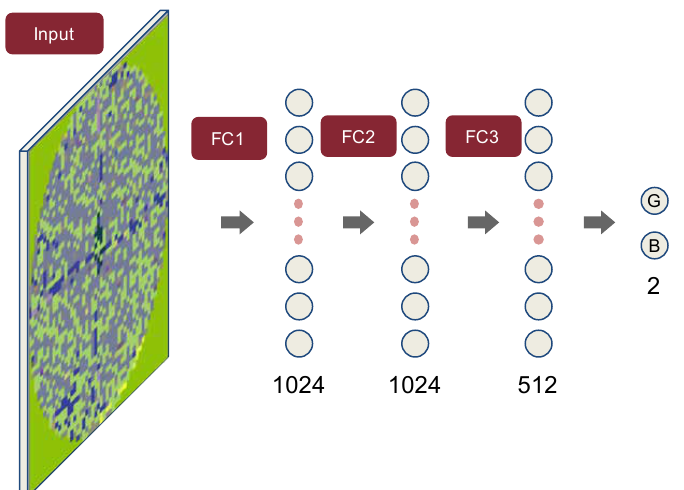
Figure 13. Multilayer perceptron architecture used in this study.